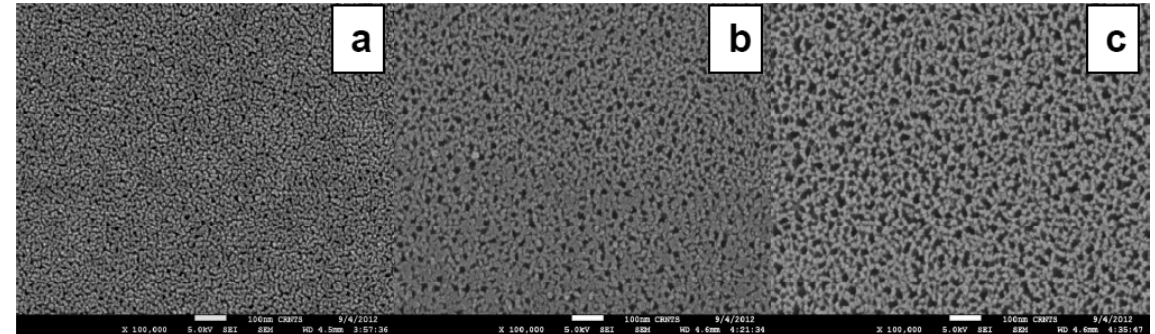
Fig. 4. Plan-view SEM images of the PSi single layers prepared with current density of (a) 10, (b) 50, and (c) 90 mA cm -2 for 2 min. Reprinted with permission from our work N.H. Maniya, S.R. Patel and Z.V.P. Murthy // Superlattice.Microst. 55 (2013) 144. (c) 2013